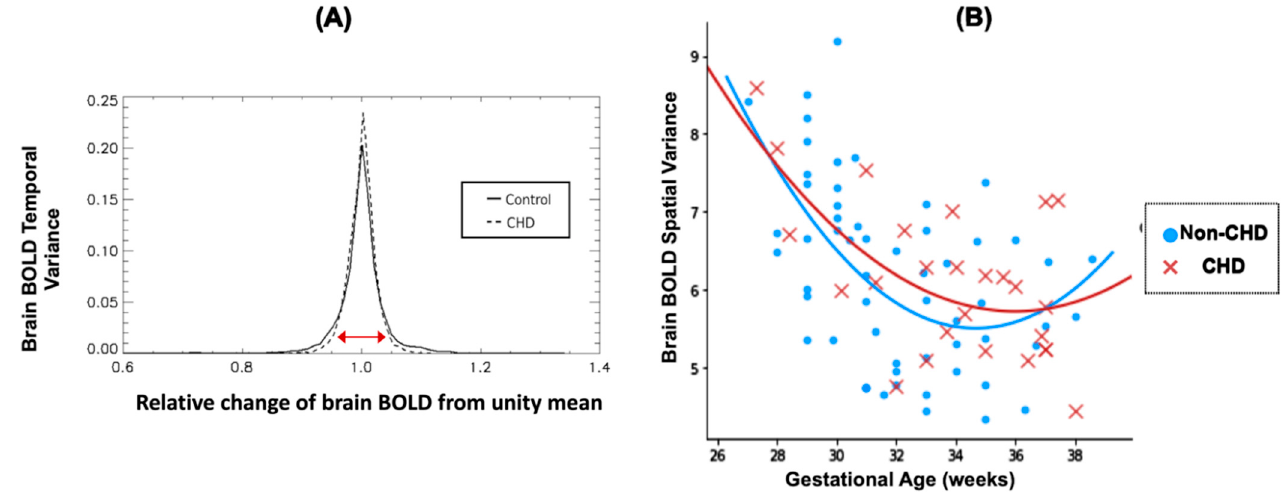
Figure 3. Spatiotemporal characteristics of intrinsic fetal brain BOLD in CHD and non ‐ CHDs: ( A ) Distribution of brain BOLD temporal variance is significantly different between CHD and non ‐ CHD groups, with CHD cases showing a smaller change from unity mean (denoted by red arrow or the width of the base of the curve) indicating reduced temporal variance of the whole fetal brain compared to the non-CHD cases ( p = 0.001). ( B ) Regression plots show no significant difference in brain spatial variance with age between CHD and non-CHD